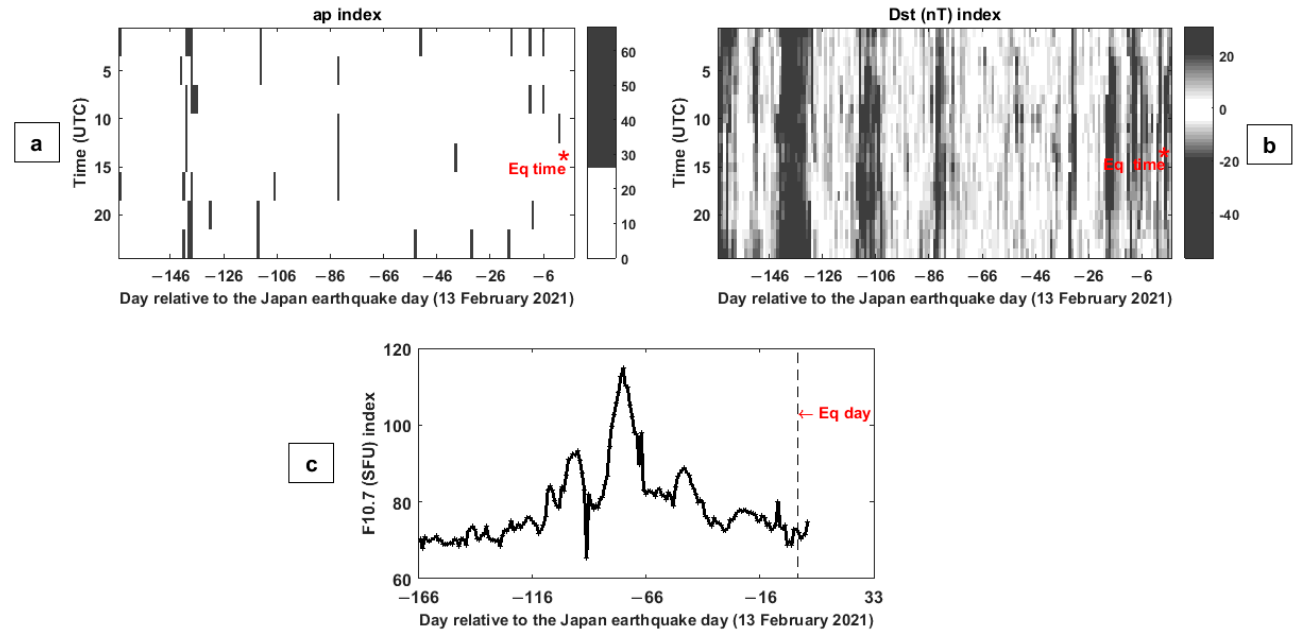
Figure 2. The variations of a p , D st and solar radio flux (F10.7) indices are shown in a – c , respectively, during the period from 1 September 2020 to 18 February 2021. An asterisk indicates the earthquake occurrence time in ( a , b ) (( a ) vertical dashed line in ( c )). The x -axis represents the day relative to the earthquake day. In ( a , b ), the shaded scale is chosen such that white indicates calm magnetic periods, while black stands for perturbed magnetic periods; the plot in ( c ) shows that F10.7 is always under the threshold of 120